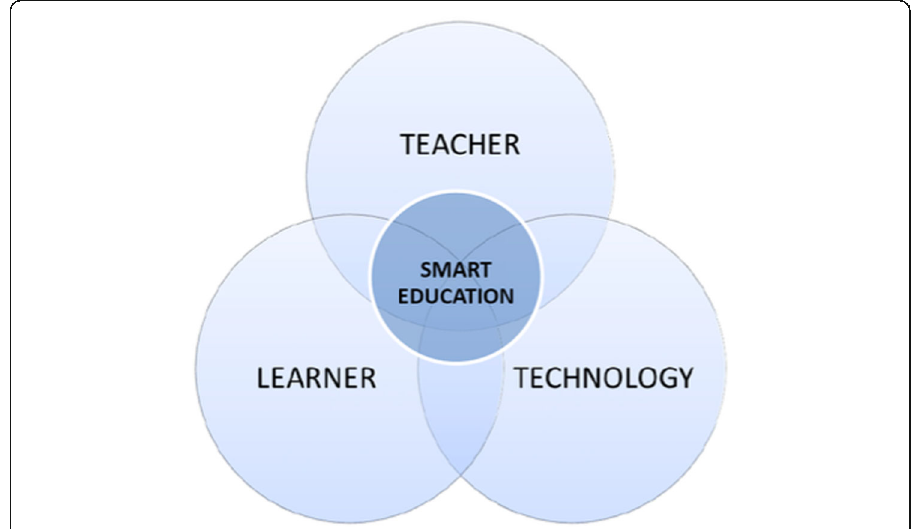
Fig. 4 Zhu et al. ’ s smart education framework (Zhu et al.,